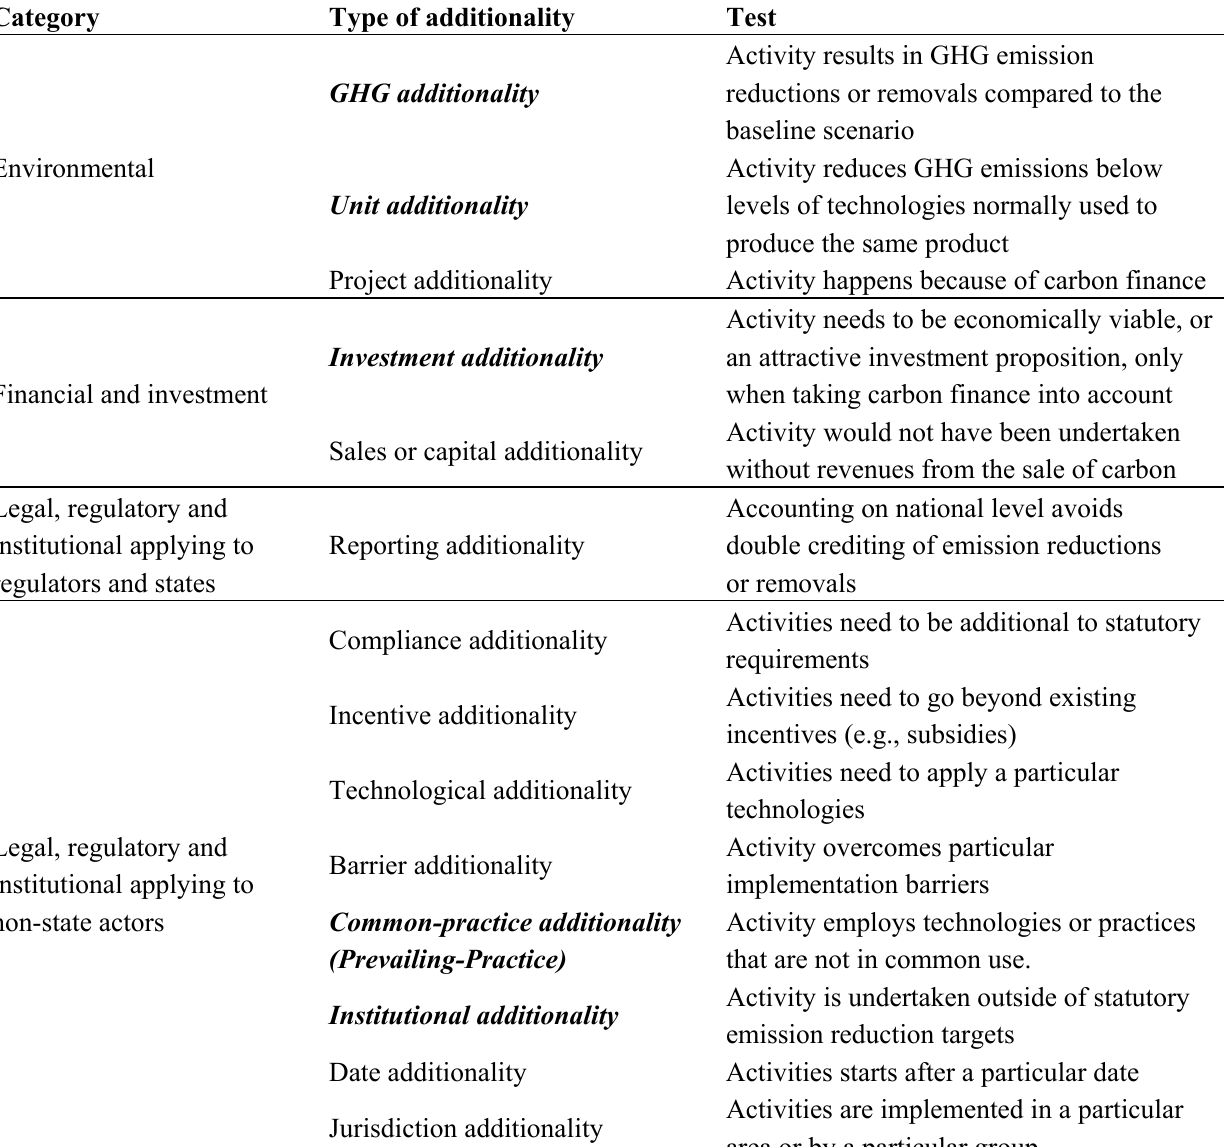
Table 1. Carbon additionality tests